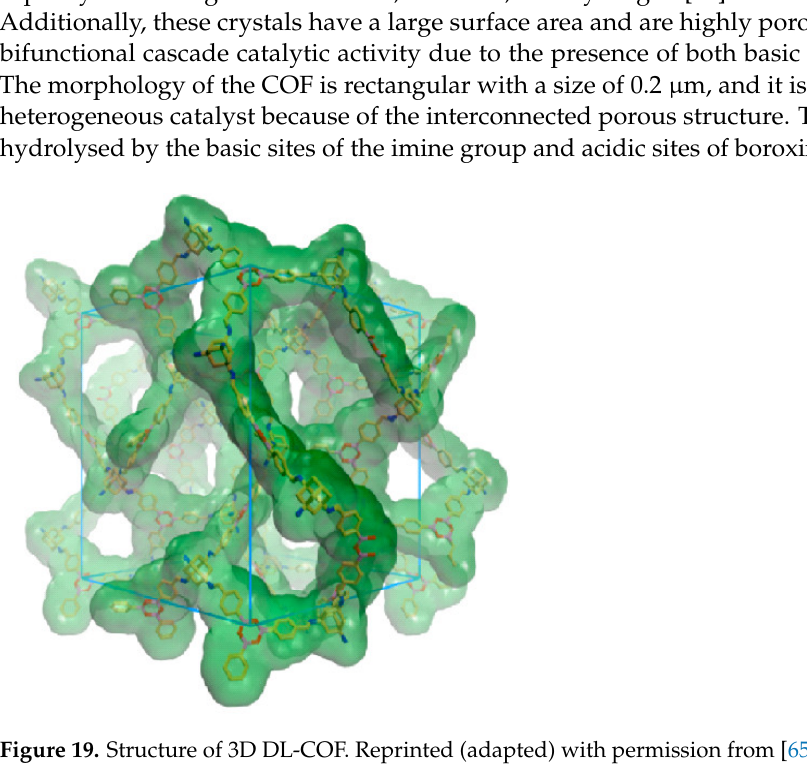
Figure 19. Structure of 3D DL-COF. Reprinted (adapted) with permission from [65]. Copyright 2016 American Chemical Society.